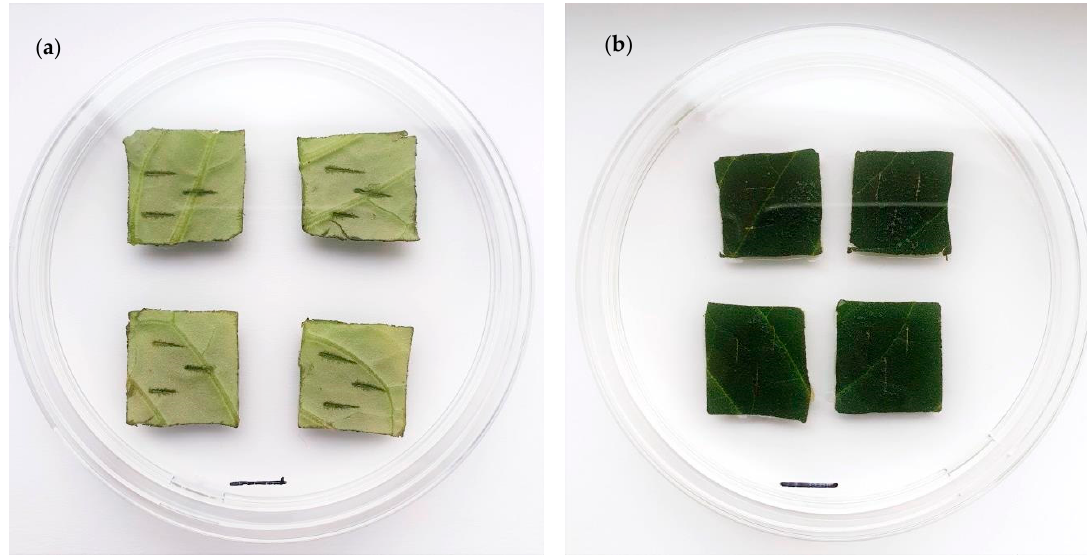
Figure 1. The explants placed on medium with the adaxial ( a ) and abaxial ( b ) side down (scale bar = 1.0 cm).